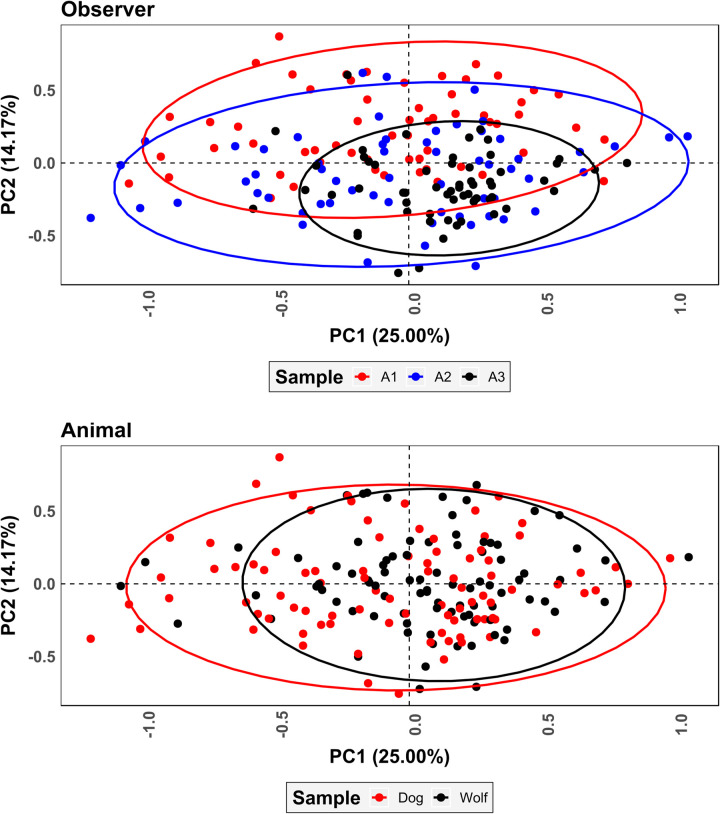
Scatter plot of principal components analysis results for fully superimposed landmark coordinates.Ellipses represent 95% confidence intervals.